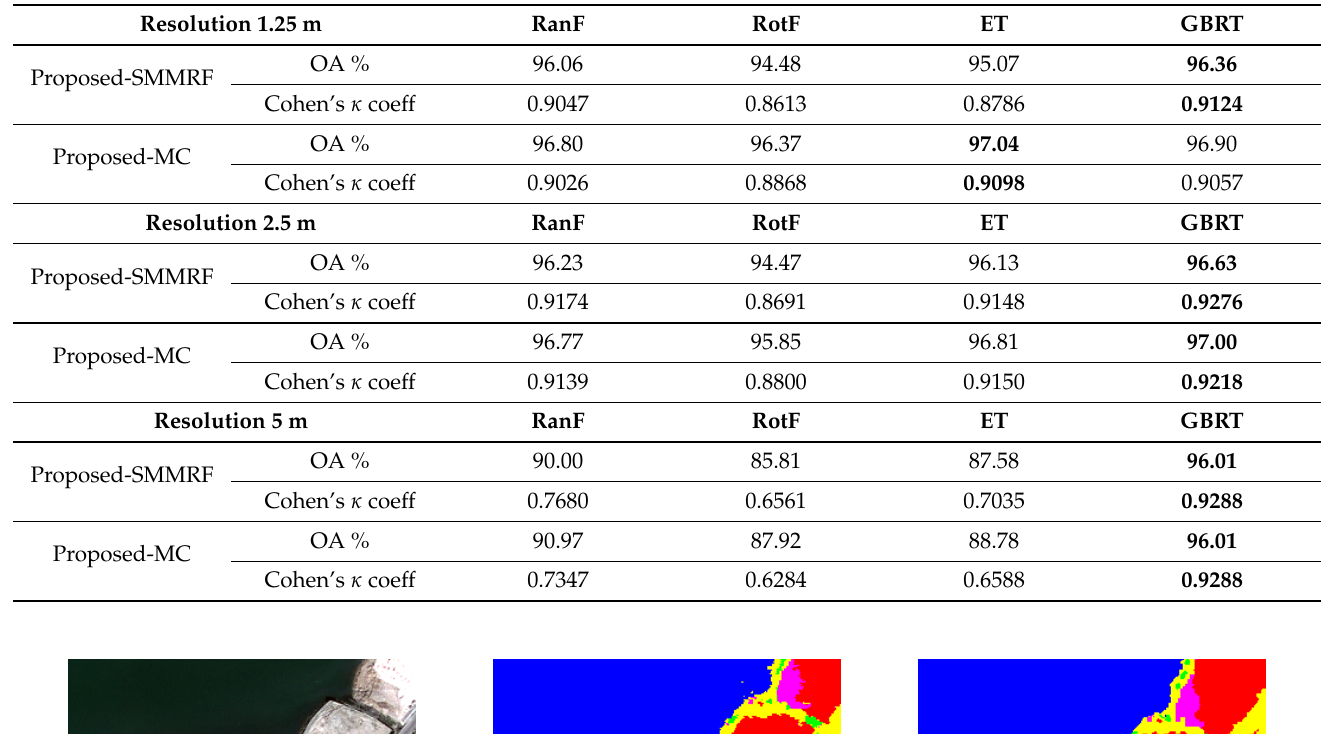
Table 1. “Haiti” dataset: OA and Cohen’s κ with respect to the test set, for the proposed methods employing SMMRF and Markov chain (MC), when combined with random forest (RanF), rotation forest (RotF), ExtraTrees (ET), and gradient boosted regression trees (GBRT).